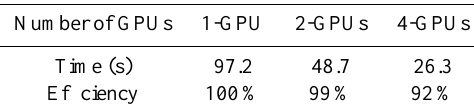
Figure 11. The weak scaling test between our communication over- lapping method and the MVAPICH2 subroutines. Table 3. The strong scaling result of POM.gpu.